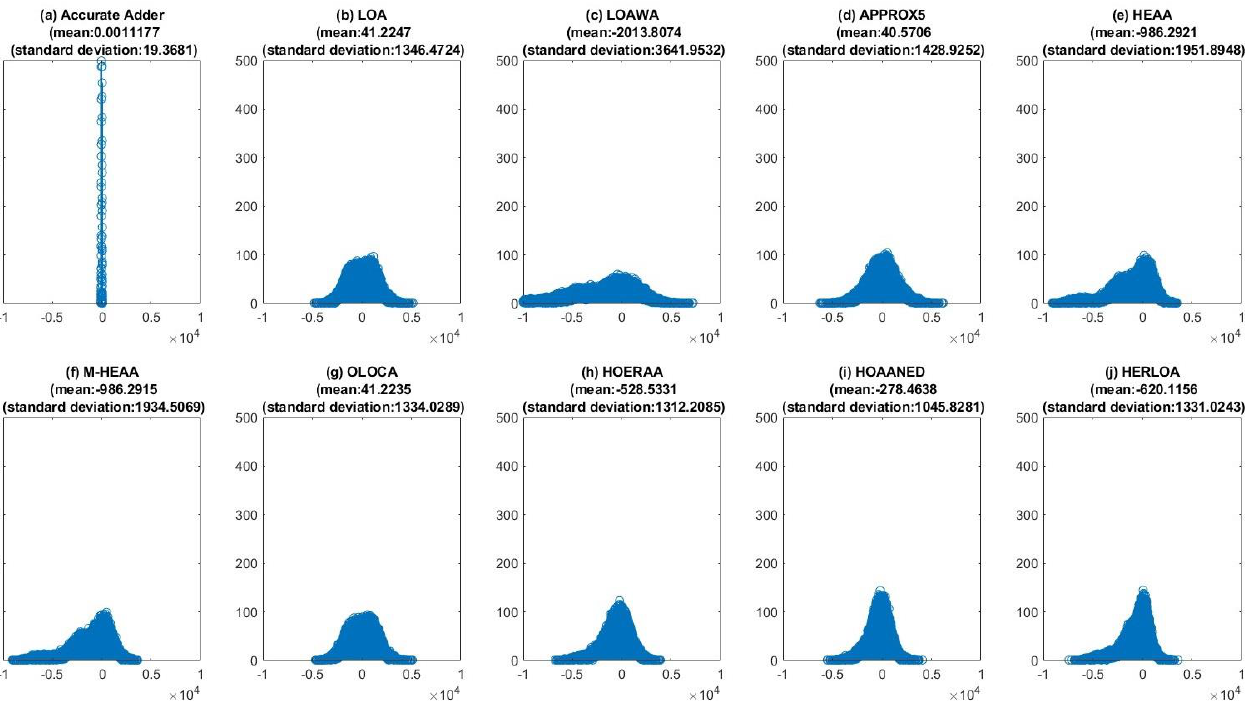
Figure 8. Plots showing the DPV between the La Silla image compressed using accurate and ap- proximate adders and the original La Silla image, with the approximate adders having a 12-bit inexact part.